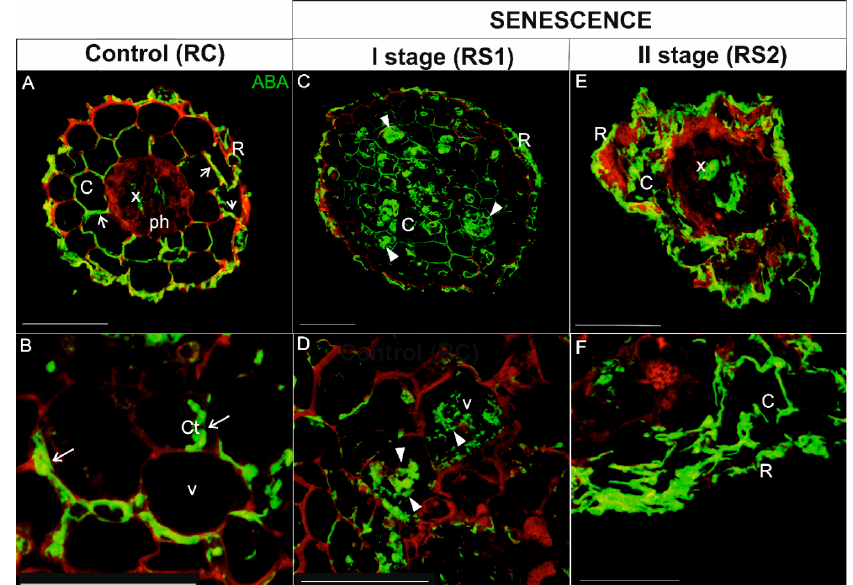
Figure 7. Immunolocalization of ABA (green fluorescence) during senescence process of fine, absorptive roots. ( A , B ) Root control (RC); ( C , D ) The first stage of root senescence (RS1); ( E , F ) The second stage of root senescence (RS2). Autofluorescence (red) of the cell wall was registered in order to visualize the cell/organ shape. Abbreviations: R, rhizodermis; C, parenchyma cortex cells; Ct, cytoplasm; Ph, phloem, X, xylem. Scale bars = 50 µm. Int. J. Mol. Sci. 2020 , 21 , x FOR PEER REVIEW